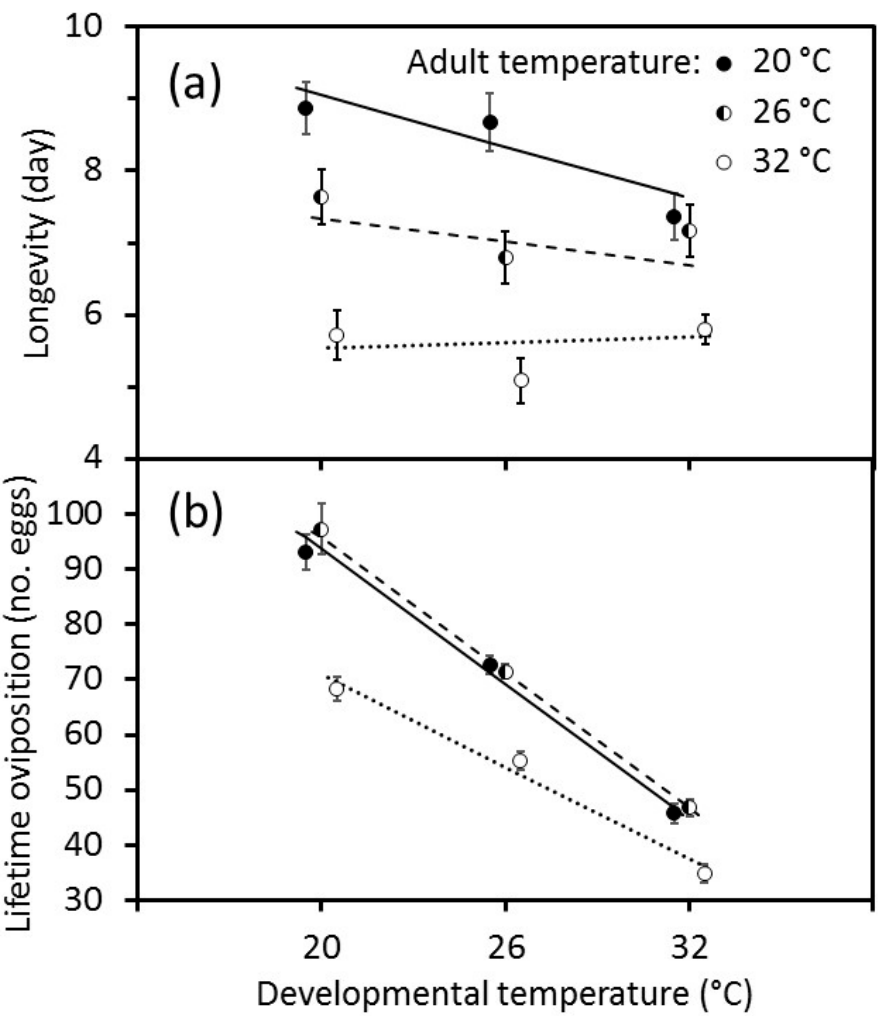
Figure 3. Effects of temperature during immature development on the ( a ) longevity and ( b ) lifetime oviposition of Eretmocerus warrae . Values are mean ± standard error. Longevity values are offset by ±0.5 °C to assist visualisation ( p < 0.001).